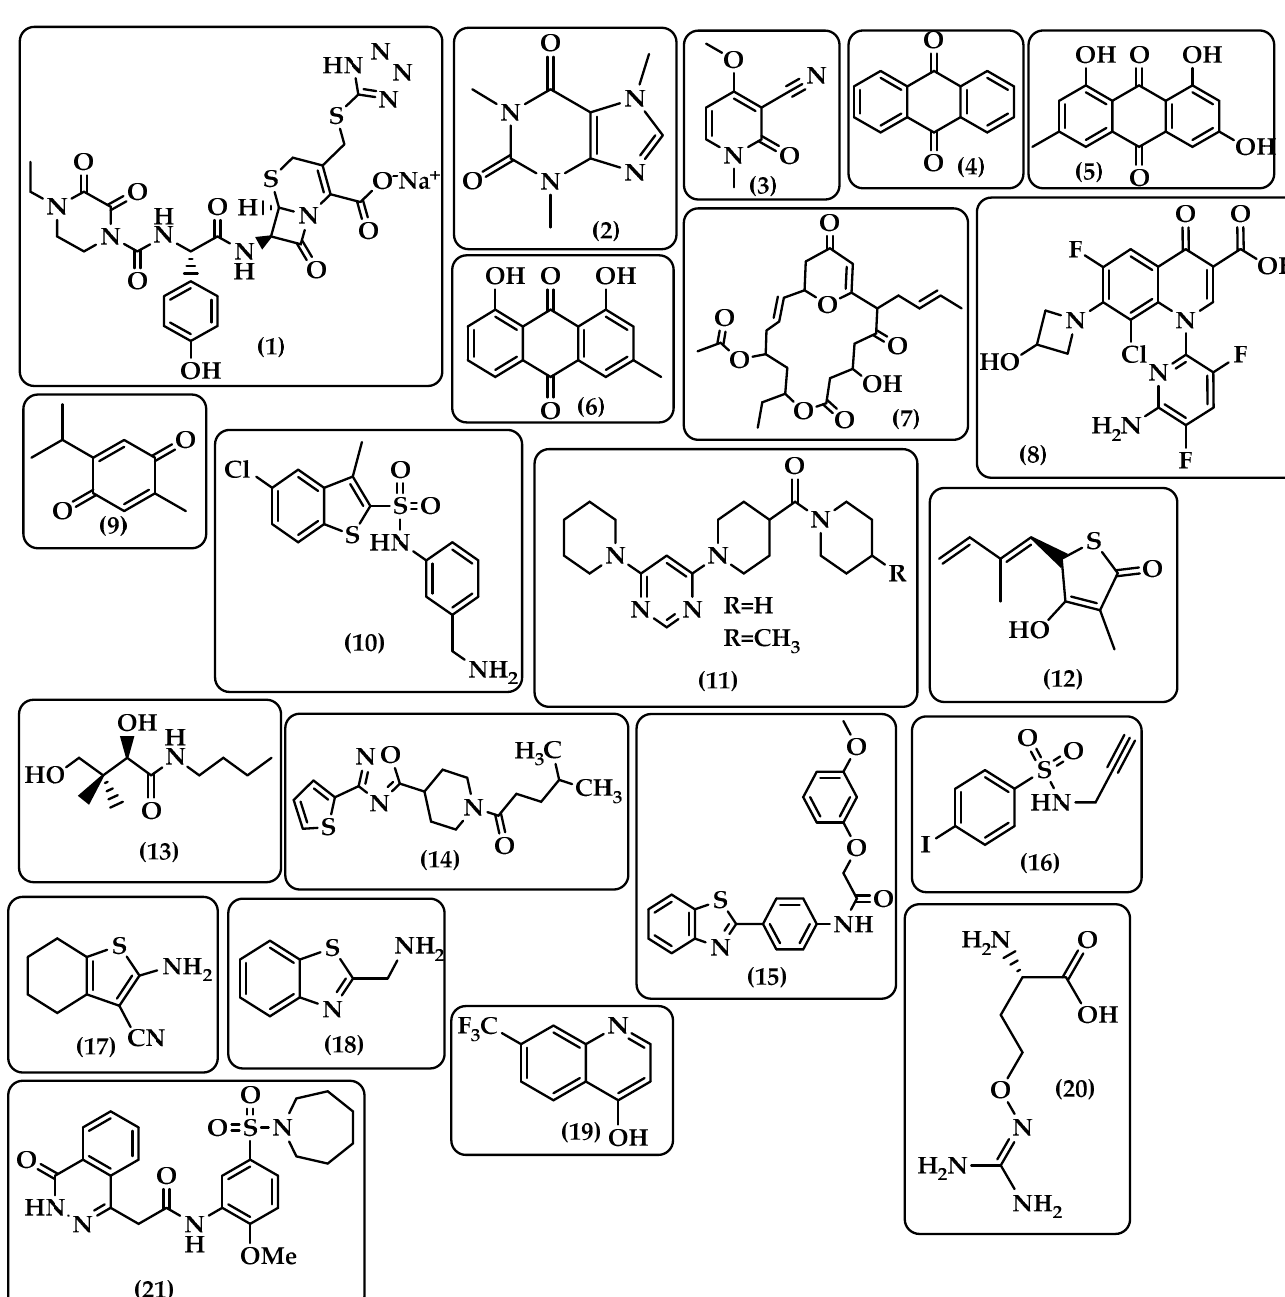
Figure 9. Chemical structure of cefoperazone sodium ( 1 ), ca ff eine ( 2 ), ricinine ( 3 ), anthraquinones ( 4 ), emodin ( 5 ), chrysophanol ( 6 ), elipyrone A ( 7 ), dela fl oxacin ( 8 ), thymoquinone ( 9 ), N -[3- (aminomethyl)phenyl]-5-chloro-3- methylbenzothiophene-2-sulfonamide ( 10 ), piperidinylpyrimidine derivatives ( 11 ), thiolactomycin (TLM) ( 12 ), pantetheine analog (PK940) ( 13 ), BDM31369 ( 14 ), BDM31827 ( 15 ), 4-Iodo- N -prop-2-ynylbenzenesulfonamide (BDM43266) ( 16 ), Tetrahydro-1-benzothiophene (THBTP) Analogue ( 17 ), 2-(aminomethyl)benzothiazole ( 18 ), NMR446 ( 19 ), L -canavanine ( 20 ), and N -(5-(azepan-1-ylsulfonyl)-2-methoxyphenyl)-2-(4-oxo-3,4-dihydrophthalazin-1-yl)acetamide ( 21 ).